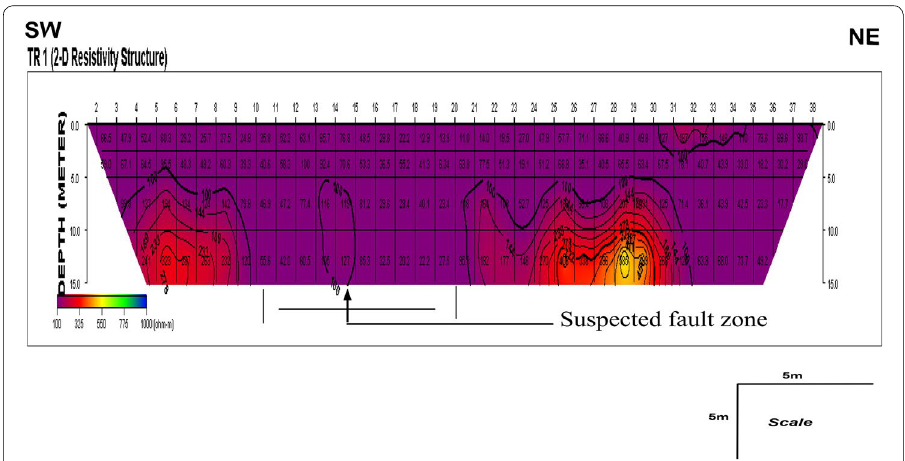
Fig. 10 2-D resistivity structure along traverse 1